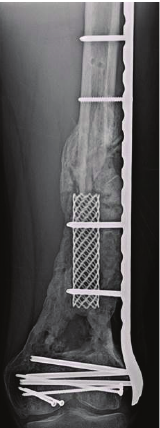
Figure 4: Radiograph demonstrating remarkable regrowth of new bone surrounding the endosteal titanium implant at 8 months post- procedure. Note the contour of the new bone, formed within the pseudocapsule which resulted from the initial antibiotic cement spacer used in the first stage of the Masquelet